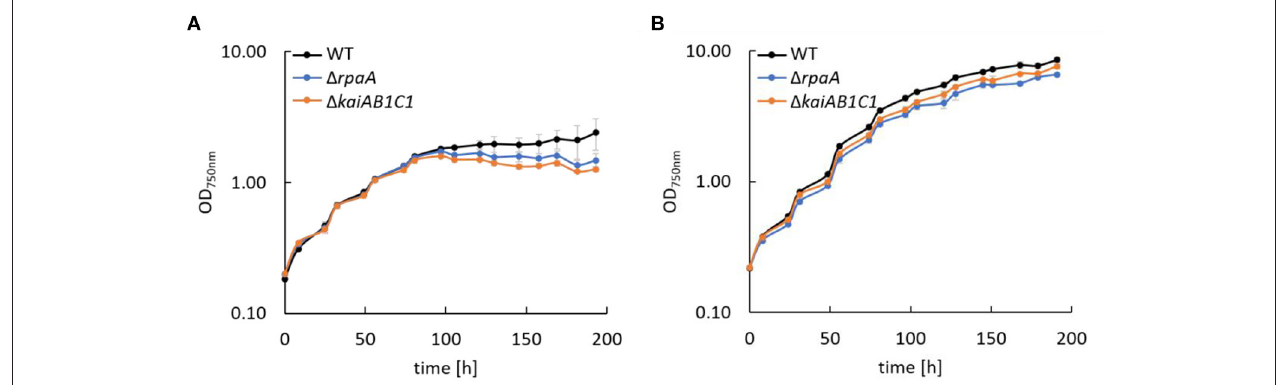
FIGURE 2 | Growth of Synechocystis mutants. Wild type (WT), 1 rpaA, and 1 kaiAB1C1 deletion mutants were grown in a 12-h L/12-h D cycle with ambient air (A) and 1% CO 2 (B) . The light intensity during cultivation was 75 µ mol photons m − 2 s − 1, which was increased to 150 µ mol photons m − 2 s − 1 in (B) after the cultures reached an OD 750 of ∼ 1. Each point represents the mean of three biological replicates ( ± standard